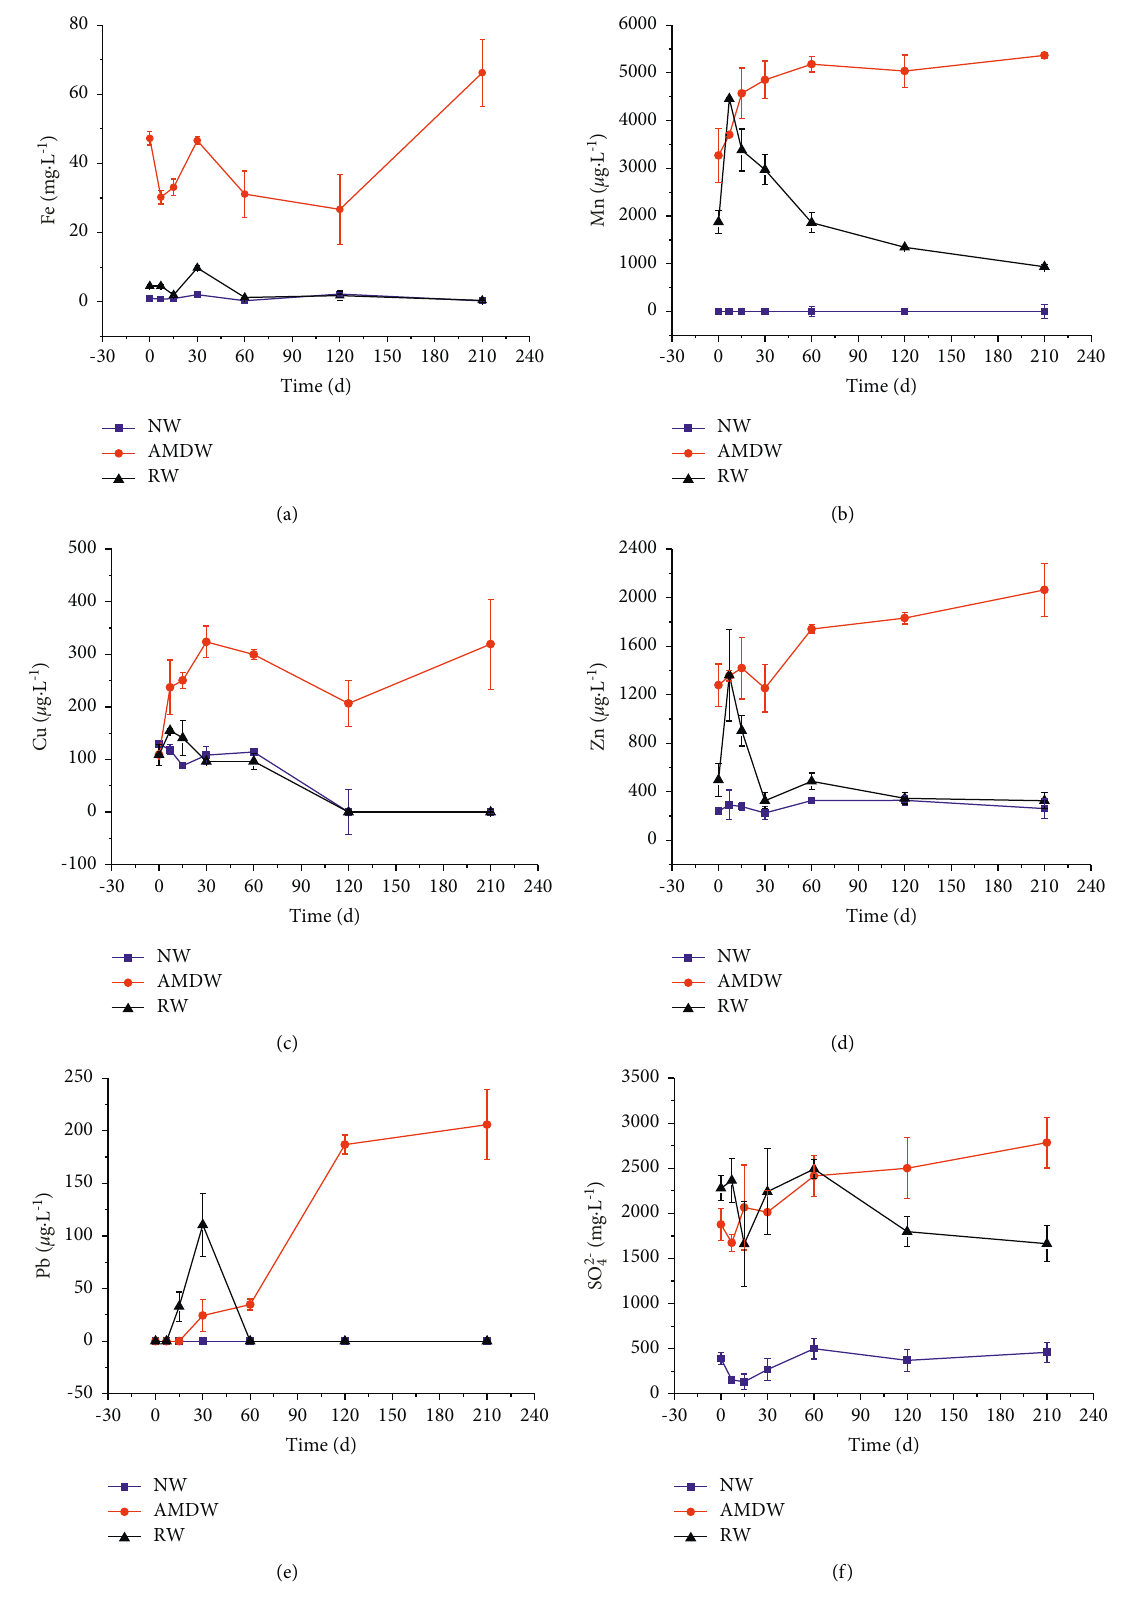
Figure 4: Concentration variation of Fe, Mn, Cu, Zn, Pb, and SO 42 − in NW, RW, and